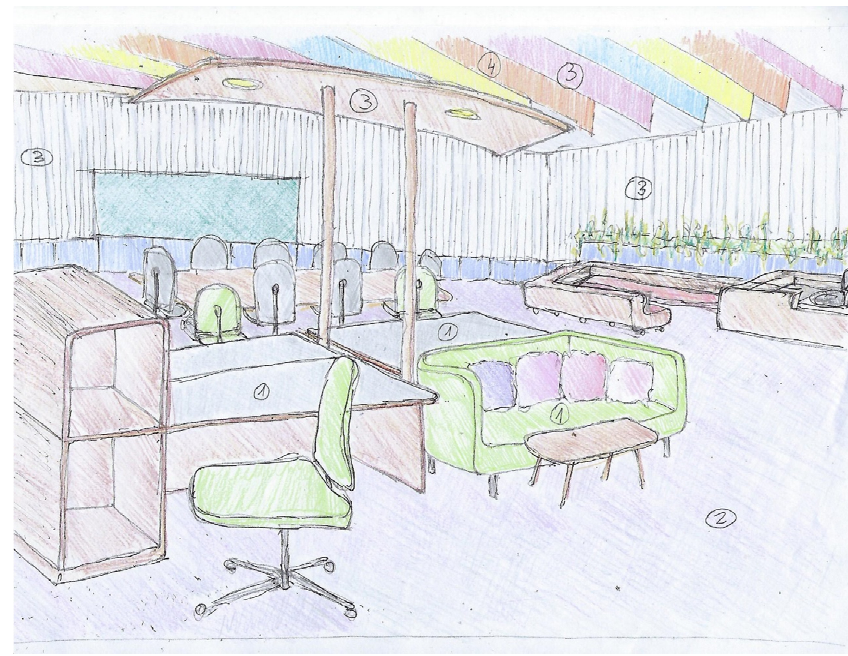
Figure 9. Sketch illustrating a friendly personal workspace ① , a wide open space ② , natural and artificial lighting ③ , and acoustic panels ④ .